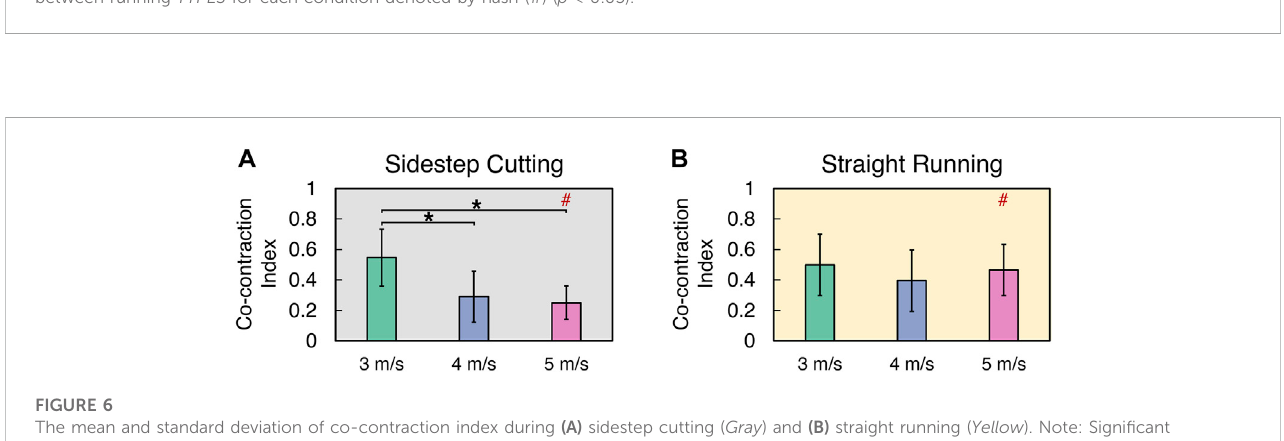
FIGURE 5 Themeanandstandarddeviationofcalculated variablesduring sidestepcutting ( Gray )andstraight running( Yellow ). (A,B) Peakkneeextension moment, (C) Peak knee abduction moment, (D) Peak knee adduction movement, (E,F) Internal rotation moment. Note: Units expressed in Newton-meters (Nm). Knee extension, adduction, and internal rotation are positive. Signi fi cant differences between VELOCITY denoted by asterisks (*) ( p < 0.05). Signi fi cant differences between running TYPES for each condition denoted by hash (#) ( p < 0.05).